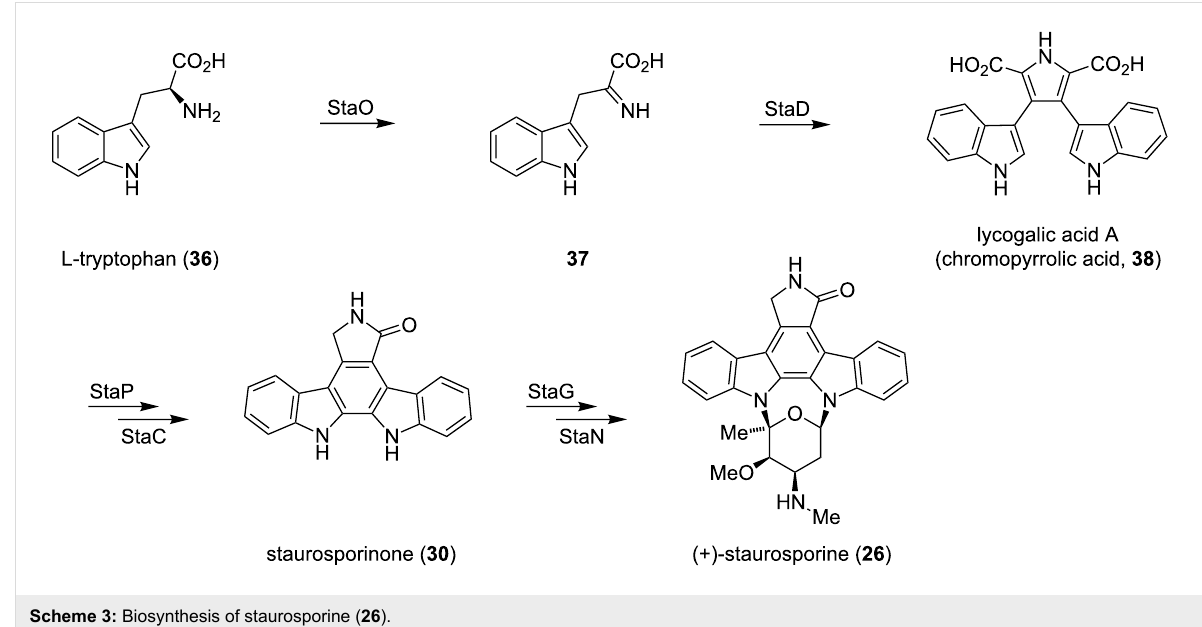
Scheme 3: Biosynthesis of staurosporine ( 26 ).